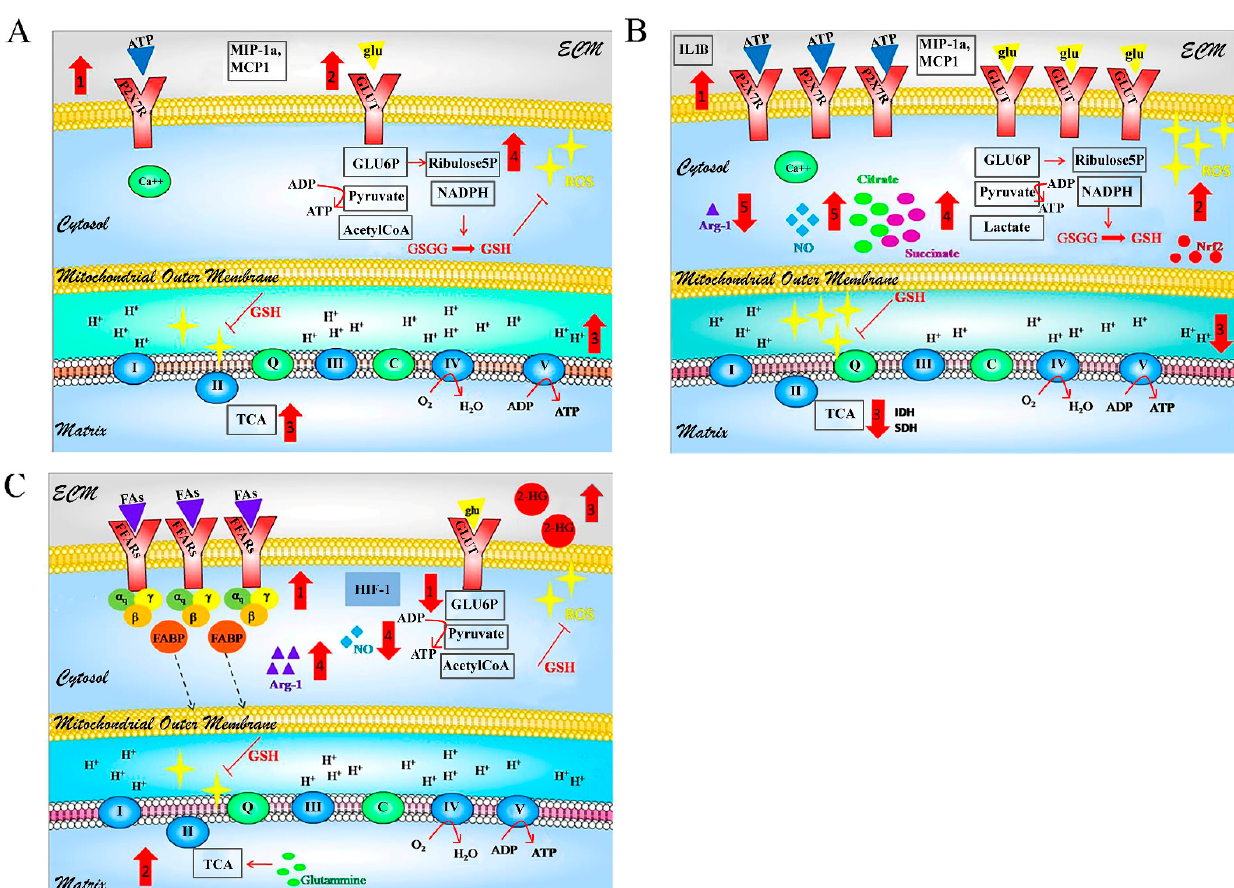
Figure 1. Glioblastoma (GBM)-associated reactive microglia. Activation phases scheme. It is proposed that the pro-inflammatory (M1) activation of microglia and macrophages includes two metabolic steps: early and late activation. ( A ) The early activation is mediated by P2X7Rs ( 1 ). Activated microglia relies on a glycolytic metabolism ( 2 ) followed by mitochondrial oxidation with an intact TCA cycle ( 3 ). A part of glucose is used in the pentose phosphate pathway (PPP) to obtain the substrates for biosynthesis and NADPH for the reduction of GSGG, gaining antioxidant power ( 4 ). ( B ) In the M1 late activation, microglia and macrophages overexpress P2X7Rs and GLUT ( 1 ). Despite the upregulation of Nrf2, excessive ROS are produced ( 2 ). ROS leads to mitochondrial impairment ( 3 ). TCA cycle has a deficient step in IDH and SDH with consequent accumulation of citrate and succinate ( 4 ), which favor the production of inflammatory cytokines. The brain microglial ROS may result in the formation of the NF-kB p50 radical, leading to the loss of function of Arg-1 and the consequent production of NO from L-arginine ( 5 ). NO drives the switch toward the aerobic glycolytic metabolism with the release of lactate. ( C ) M2 activation. The lactate in the ECM and the tumor-induced hypoxia stabilize the HIF1- α while the condition of glucose starvation constrains the cells to FAO metabolism ( 1 ) and mitochondrial rewiring. Glutamine-derived compounds enter the TCA cycle (anaplerosis) or are involved in the GSH synthesis ( 2 ). HIF- α and 2-HG restrain the inflammatory genes and promote anti-inflammatory behavior ( 3 ). Arg-1 upregulation reduces the substrate availability for the inducible nitric oxide synthase (iNOS) with consequent NO reduction ( 4 ). All the figures consider the metabolic changes and do not include the nuclear compartment. More detail in the text. ECM = extracellular matrix; ATP = adenosine triphosphate; P2X7Rs = purinergic receptor X7; MIP-1 α = macrophage inflammatory protein 1-alpha; MCP1 = monocyte chemoattractant protein 1; glu = glucose; GLUT = Glucose Transporter; glu6P = glucose 6-phosphate; NADPH = nicotinamide adenine dinucleotide phosphate hydrogen; ROS = reactive oxygen species; GSGG = oxidized glutathione; GSH = Reduced glutathione; Ca 2+ = calcium ion; I,II,III,IV,V = mitochondrial complex of phosphorylation electron chain; Q = coenzyme Q; C = cytochrome c oxidoreductase; TCA = tricarboxylic acid cycle; Nrf2 = Nuclear factor erythroid 2-related factor 2; Il-1 β = Interleukin 1 beta; IDH = Isocitrate dehydrogenase; SDH = Succinate dehydrogenase; HIF-1 = Hypoxia-inducible factor 1; FAs = fatty acids; FFARs = free fatty acids receptor; α q- β - γ = G proteins coupled to receptor; FABP = fatty acid-binding protein; Arg-1 = Arginase-1; 2-HG = 2-hydroxyglutarate; NO = nitric oxide. Figure 1 was partially drawn using the Network Painter open-source tool from Stanford